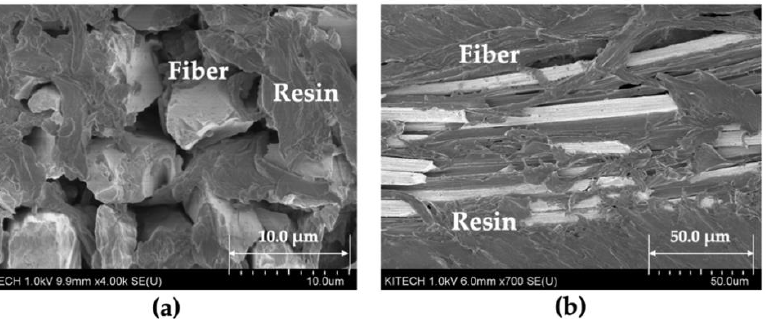
Figure 9. SEM images of the 4-MF (3k) composites: ( a ) cross-section of warp; ( b ) cross-section of weft.